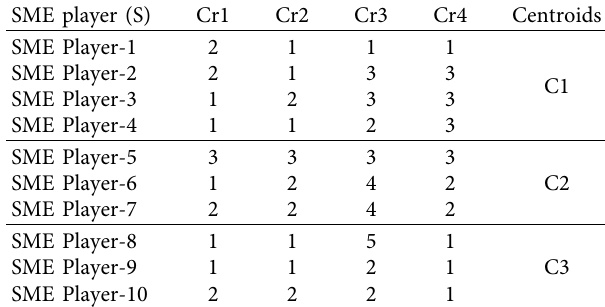
Table 15: Cluster data in the first iteration.